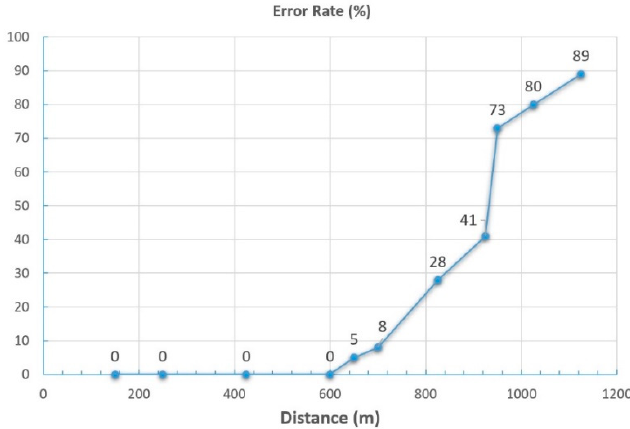
Figure 12. Error rates in the transmission of images from the remote RICS nodes to the local coordinator node, as a function of the distance between them. The speed is 19,200 bps and the resolution is 320 × 240 pixels.